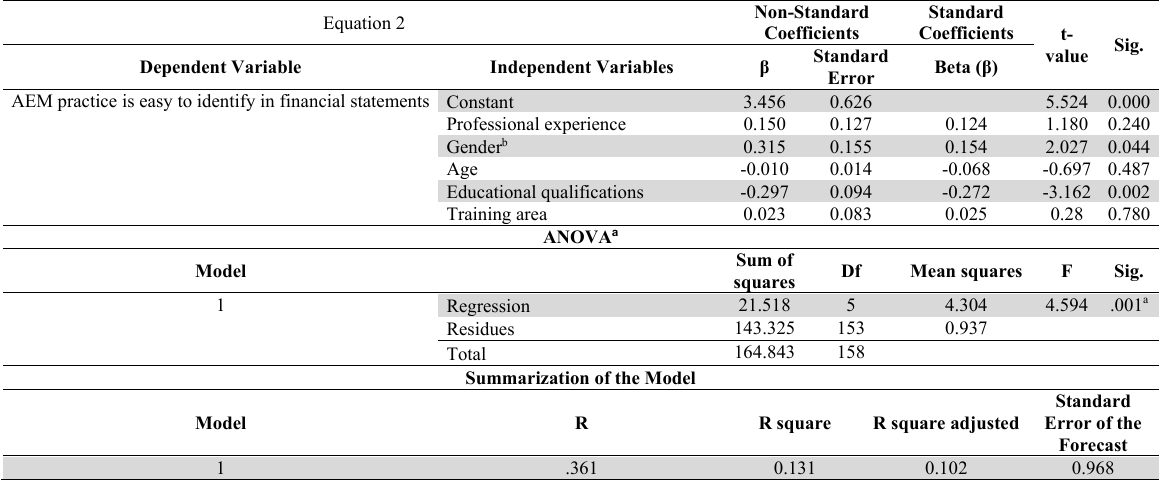
ease of identifying AEM